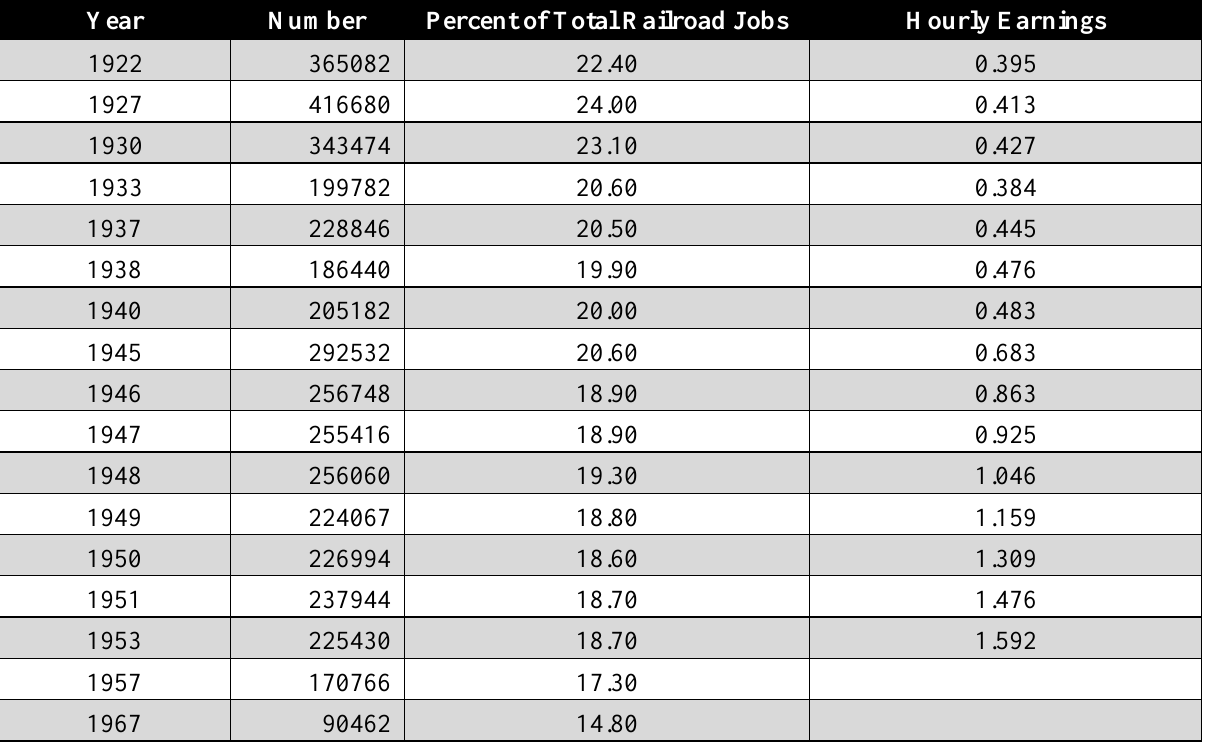
Table 1. Maintenance of Way Employment over